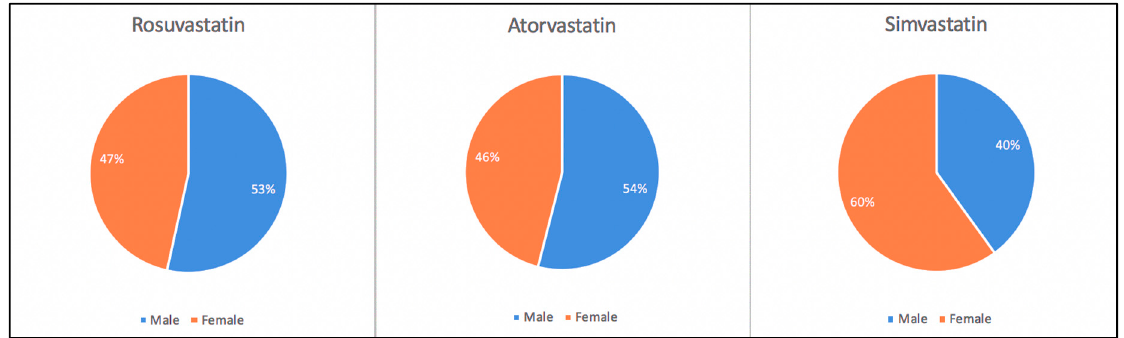
Figure 1. Types of statins administered in our study group.